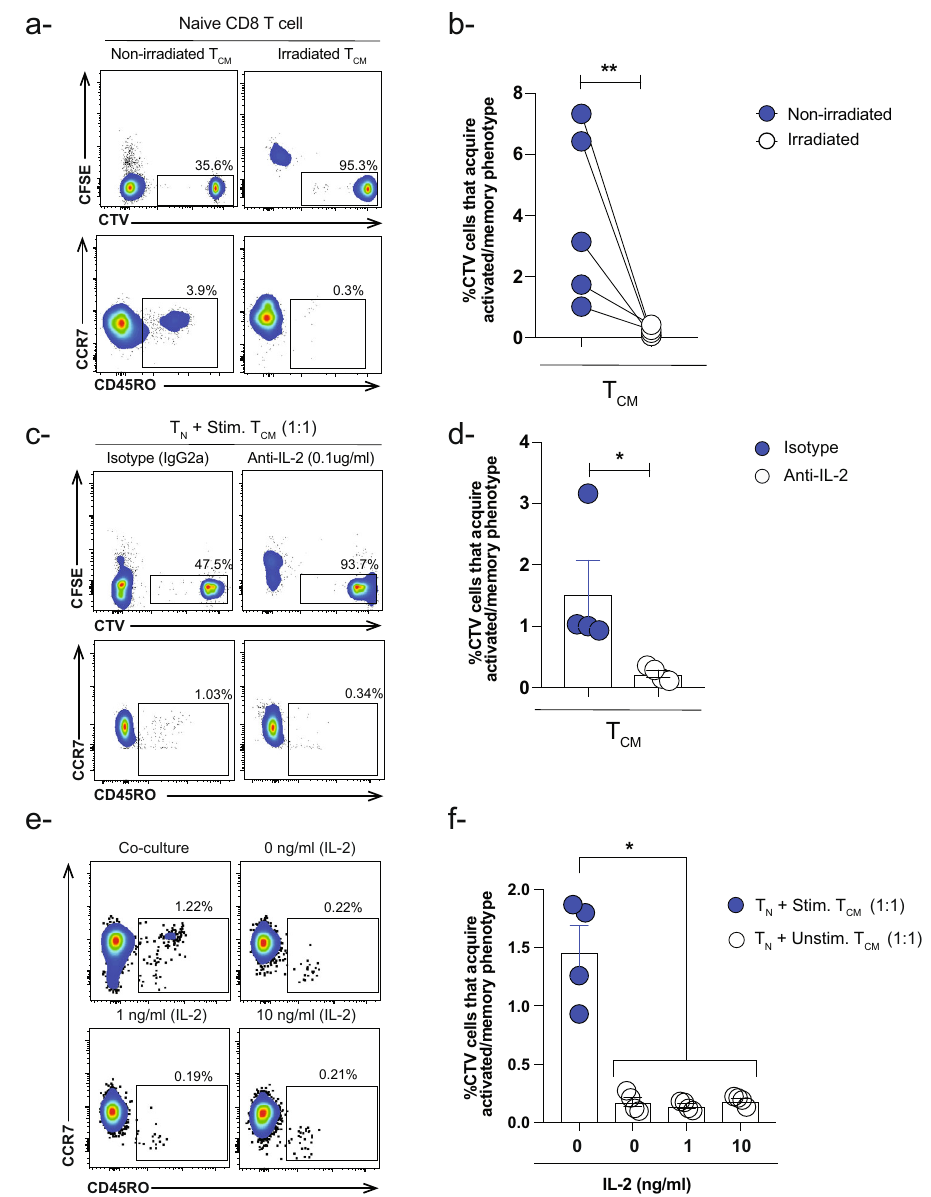
Fig. 3 Proliferation of activated memory CD8 T cell subsets in fl uence the phenotype of naïve CD8 T cells. a Representative fl ow cytometry plots and b paired-analysis showing the frequency of naïve CD8 T cells that acquired activated/memory phenotype in the presence of activated non-irradiated and irradiated T CM CD8 T cells (memory:naïve-3:1 ratio). Wilcoxon test (paired nonparametric t-test) was used **P < 0.01. Data are presented as means ± SEM ( n = 5 healthy donors) c Representative fl ow cytometry plots and d Bar-graph showing the effect of anti-IL-2 human antibody (0.1 μ g/ml) on the frequency of naïve CD8 T cells that acquired activated/memory phenotype in the presence of activated T CM CD8 T cells (1:1) ratio. Isotype IgG2a was used at the same concentration as a control ( n = 4). Unpaired nonparametric Mann-Whitney test was used. Data are presented as means ± SEM *P < 0.05. e Representative fl ow plots and f Bar-graph showing the frequency of CTV-labeled naïve CD8 T cells that acquired activated/memory phenotype in the presence of unstimulated T CM CD8 T cells (1:1 ratio) and different concentrations of exogenous rhIL-2 compared to regular co-culture conditions (T N + stimulated T CM 1:1). Ordinary one-way ANOVA Bonferroni multiple comparison test was used *P < 0.05. Data are presented as means ± SEM ( n =